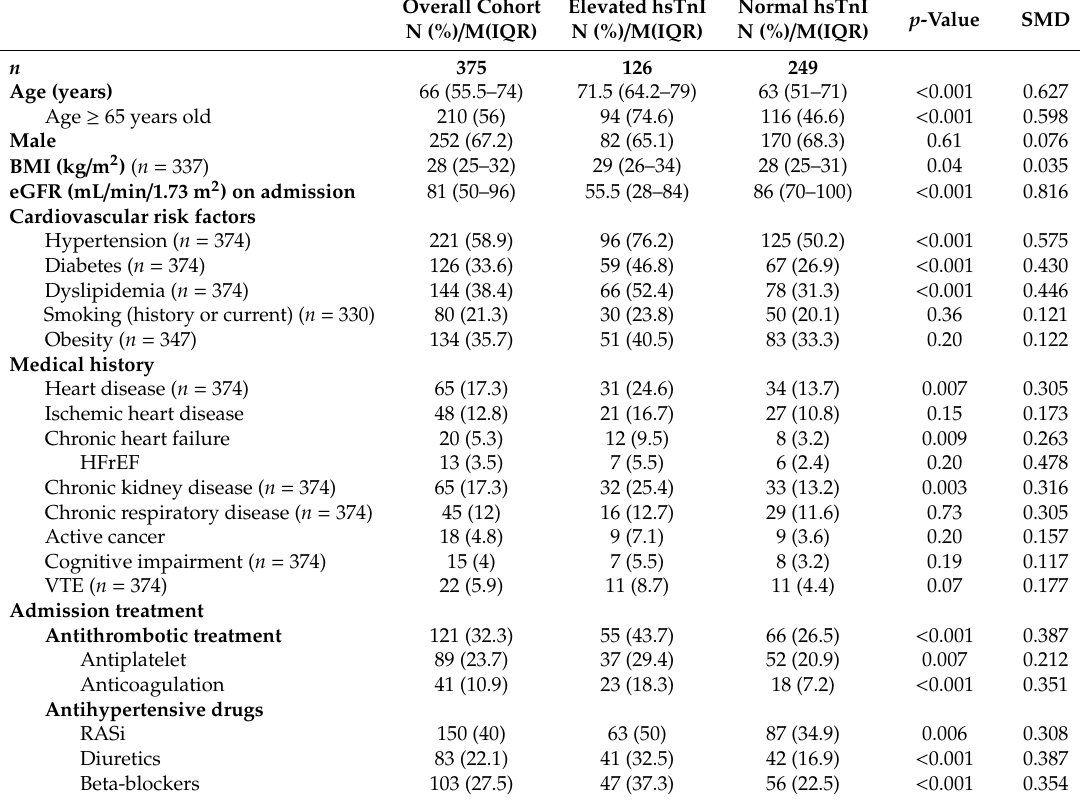
Figure 1. Study flowchart showing patient selection. COVID-19: Human Coronavirus Disease 2019; Feb: February; h: hours; hs: high-sensitivity; SARS-CoV-2: severe acute respiratory syndrome coronavirus 2. Table 1. Baseline characteristics and in-hospital outcomes.